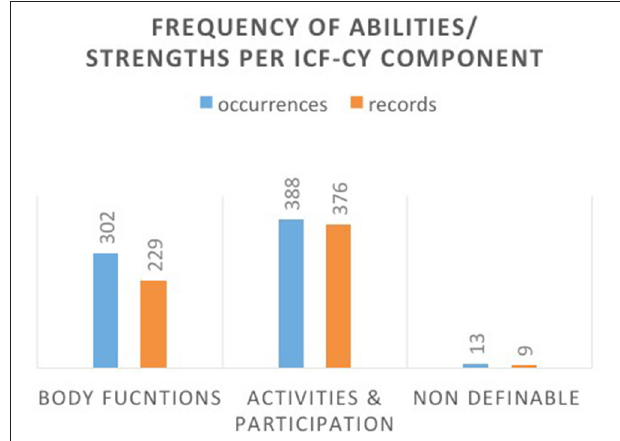
FIGURE 1 | Frequency of strengths/abilities in section A of the plans, matched with the ICF-CY classification system.